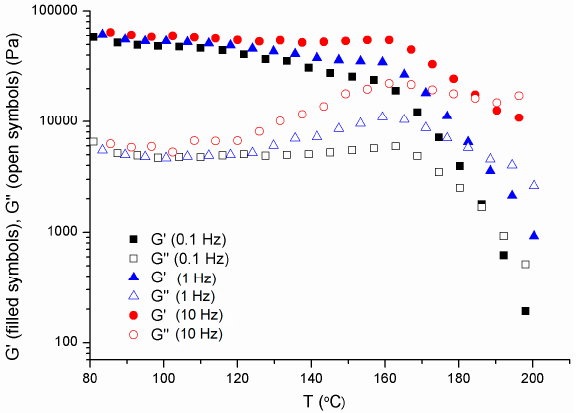
Figure 5. Shear elastic (G ′ ) and viscous (G‘’) moduli vs. temperature taken at constant corresponding frequencies of 0.1, 1, and 10 Hz for the sample PVC/40DINP.